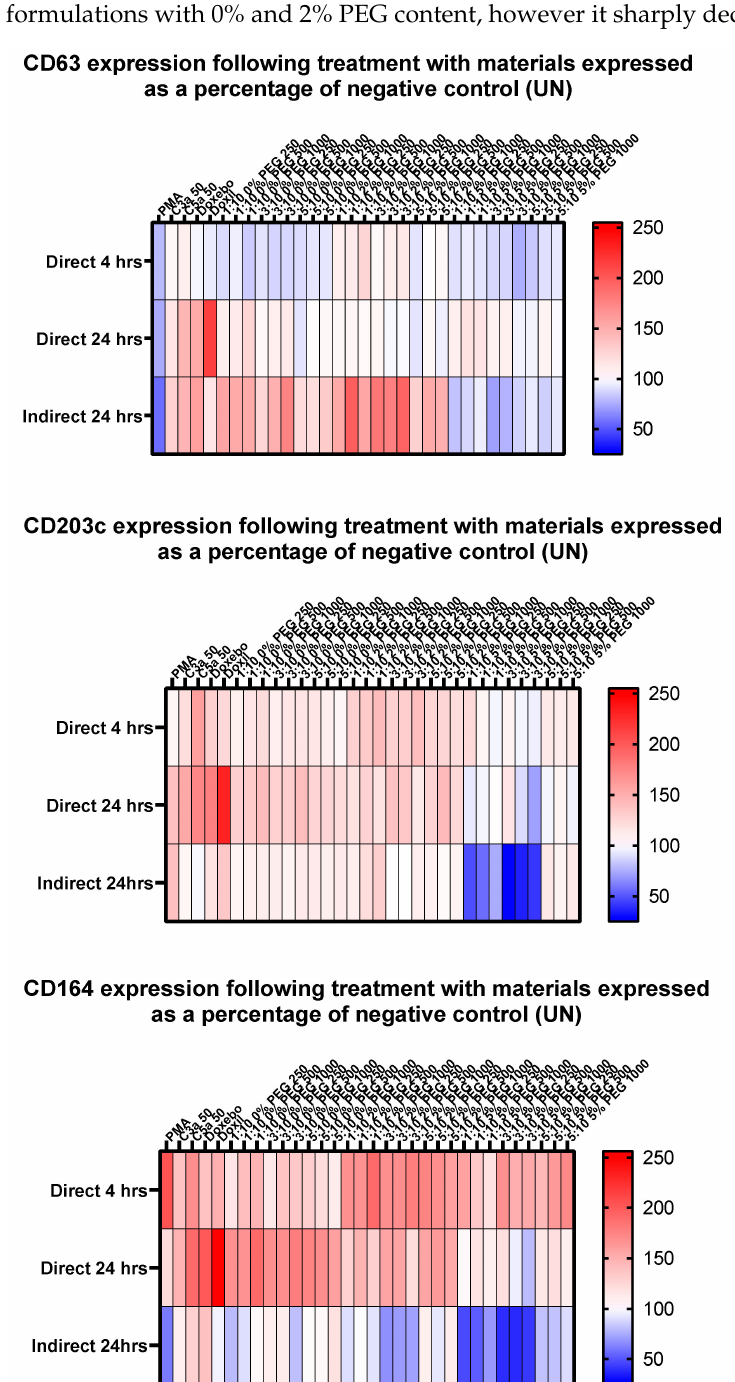
Figure 9. The levels of basophil activation markers, following incubation alongside various test materials. Values shown as a percentage of the negative control (Untreated). Concentrations shown are stated in ng/mL unless otherwise stated. Values shown are means calculated from n =